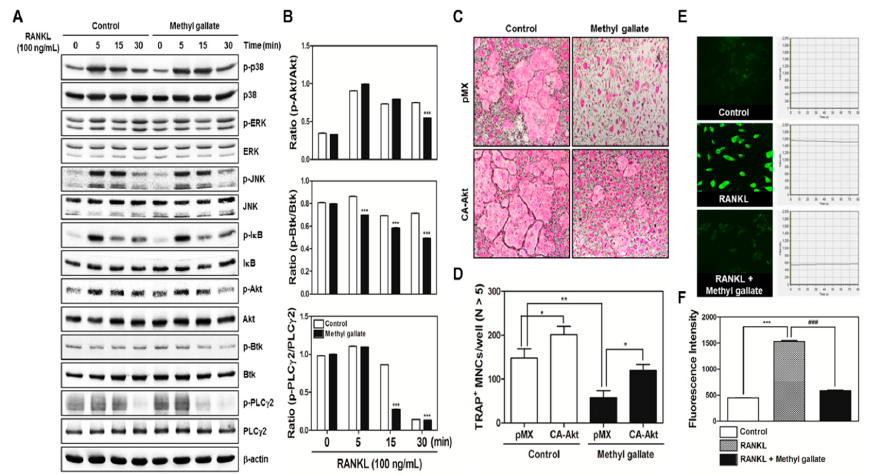
Figure 2. Methyl gallate suppresses phosphorylation of Akt, Btk, and PLC γ 2. ( A ) BMMs were preincubated with or without methyl gallate (10 µ M) for 1 h in the presence of M-CSF (30 ng/mL) before RANKL (100 ng/mL) stimulation at the indicated time points. Whole-cell lysates were analyzed by Western blotting with the indicated antibodies. β -Actin was used as internal control; ( B ) Quantification of relative ratio of band intensity was performed using Image J software. *** p < 0.001; ( C ) BMMs were infected with retroviruses expressing pMX-IRES-EGFP (pMX) and pMX-CA-Akt-EGFP. The infected BMMs were cultured with or without methyl gallate (10 µ M) in the presence of M-CSF (30 ng/mL) and RANKL (100 ng/mL) for 4 days. After that, the cells were fixed and stained with a TRAP solution. TRAP-positive cells were photographed under a light microscope at the indicated magnification (10 × ); ( D ) The number of TRAP-positive MNCs (nuclei > 5) was counted in these cultures. * p < 0.05; ** p < 0.01; ( E ) BMMs were incubated with M-CSF (30 ng/mL) and RANKL (100 ng/mL) in the presence or absence of methyl gallate (10 µ M) for 3 days. For Ca 2+ quantification, the cells were incubated with Fluo-3/AM for 30 min in serum-free-MEM followed by confocal imaging analysis at the indicated magnification (40 × ). Each line shows the fluorescence intensity of the respective condition. The fluorescence intensity in each group was recorded within 80 s; ( F ) The intensity of Fluo-3/AM was statistically analyzed at time point 80 s. *** p < 0.001; ### p <